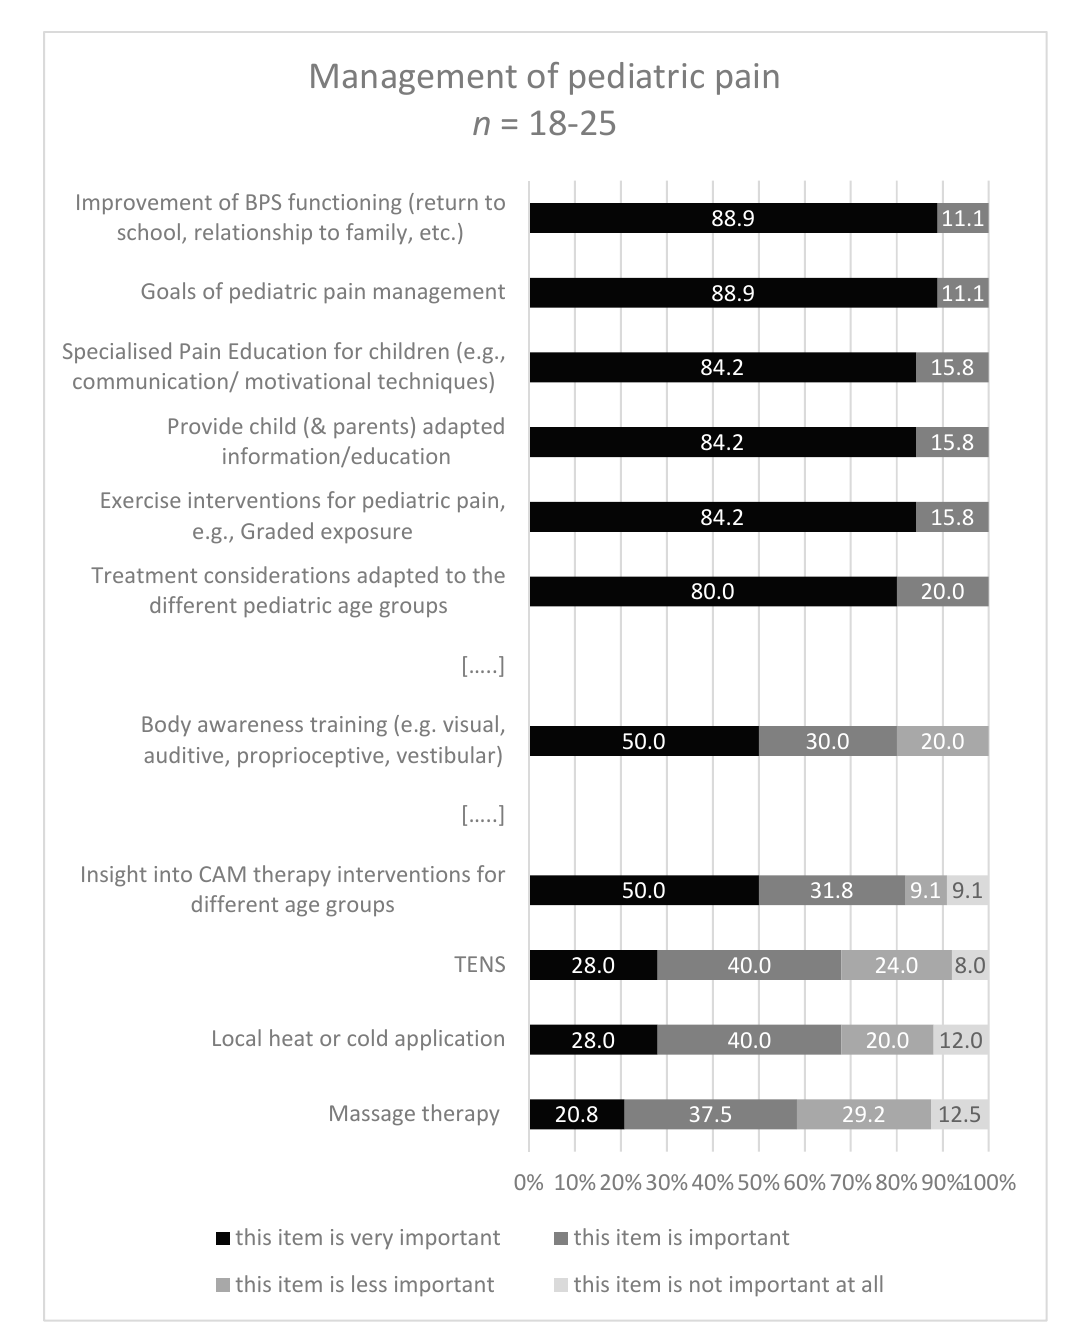
Figure 5. Response categories with highest/lowest accordance in area 3 (Management). […..]: omission of items. BPS: biopsychosocial; CAM: complement & alternative therapy interventions